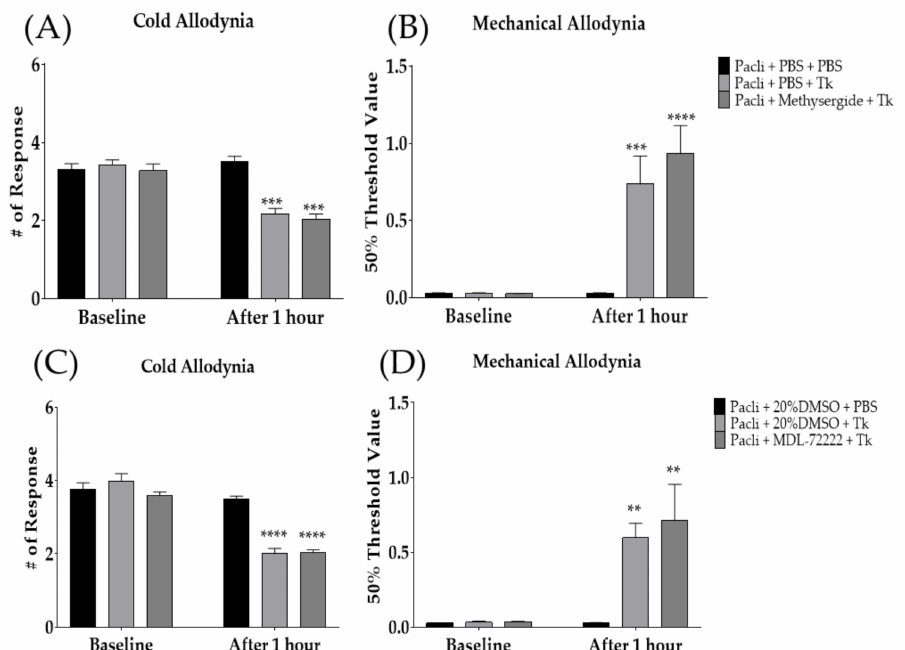
Figure 5. Analgesic effect of Tk following intrathecal injection of methysergide ( A , B ) or MDL-72222 ( C , D ) was assessed on cold ( A , C ) and mechanical ( B , D ) allodynia. Methysergide and MDL-72222 are 5-HT 1/2 and 5-HT 3 -receptor antagonists, respectively. PBS and 20% DMSO were administered intrathecally as a control to methysergide and MDL-72222, respectively. Pacli: paclitaxel, Tk: